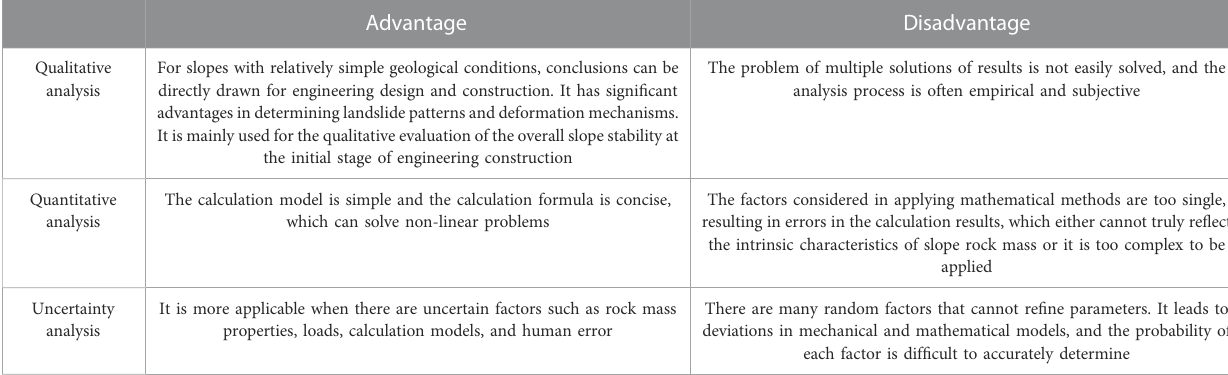
TABLE 1 Advantages and disadvantages of common stability analysis